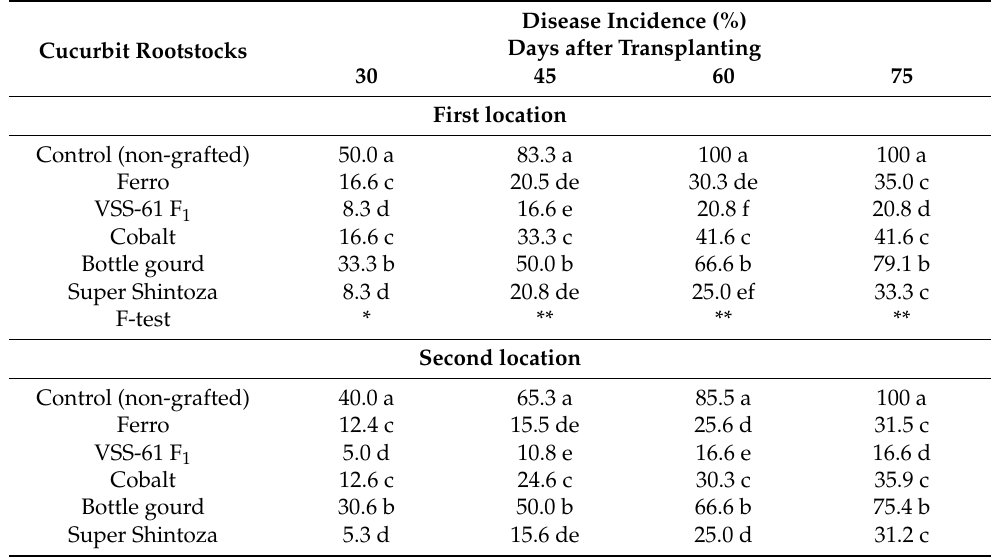
Table 1. Response of cucumber plants grown in greenhouse grafted onto different rootstocks to fusarium wilt under disease pressure and heat stress in both